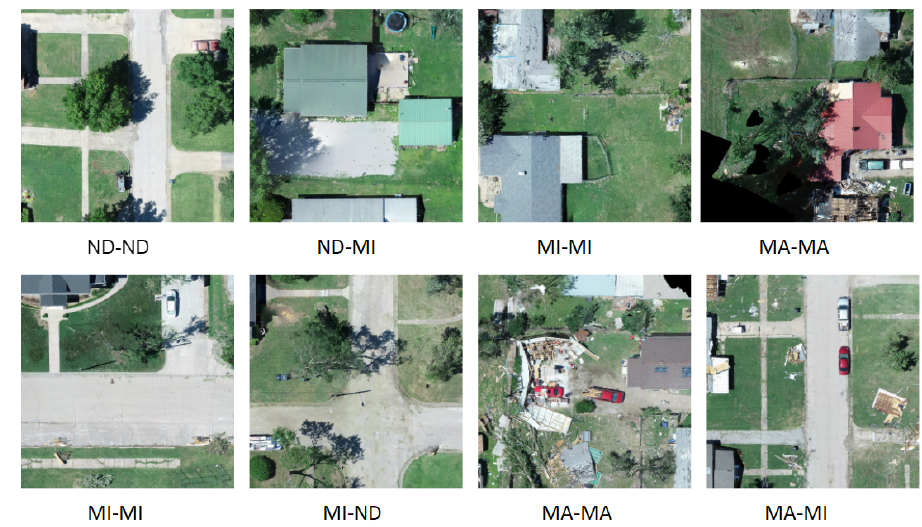
Figure 7. Examples of neural network inference and ground truth for multi-class image classification from validation and test datasets. ND: no damage, MI: minor damage, and MA: major damage. The legend below every subfigure shows ground-truth label and prediction label; e.g., MI-ND means ground-truth annotation is minor damage and neural network classified the same tile as no